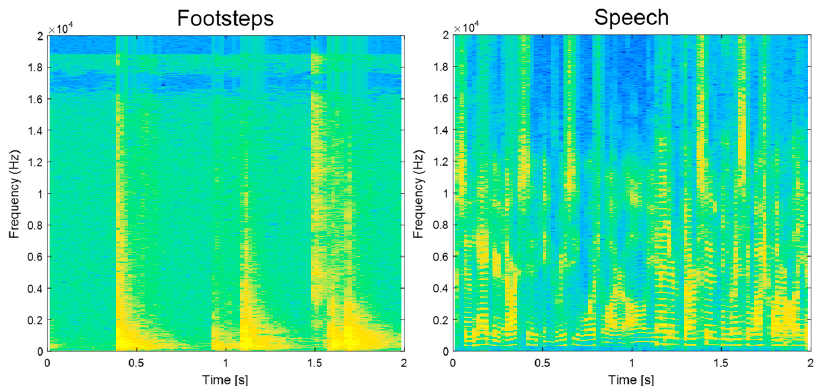
Figure 4. Example of time-frequency representation of four sound event classes.